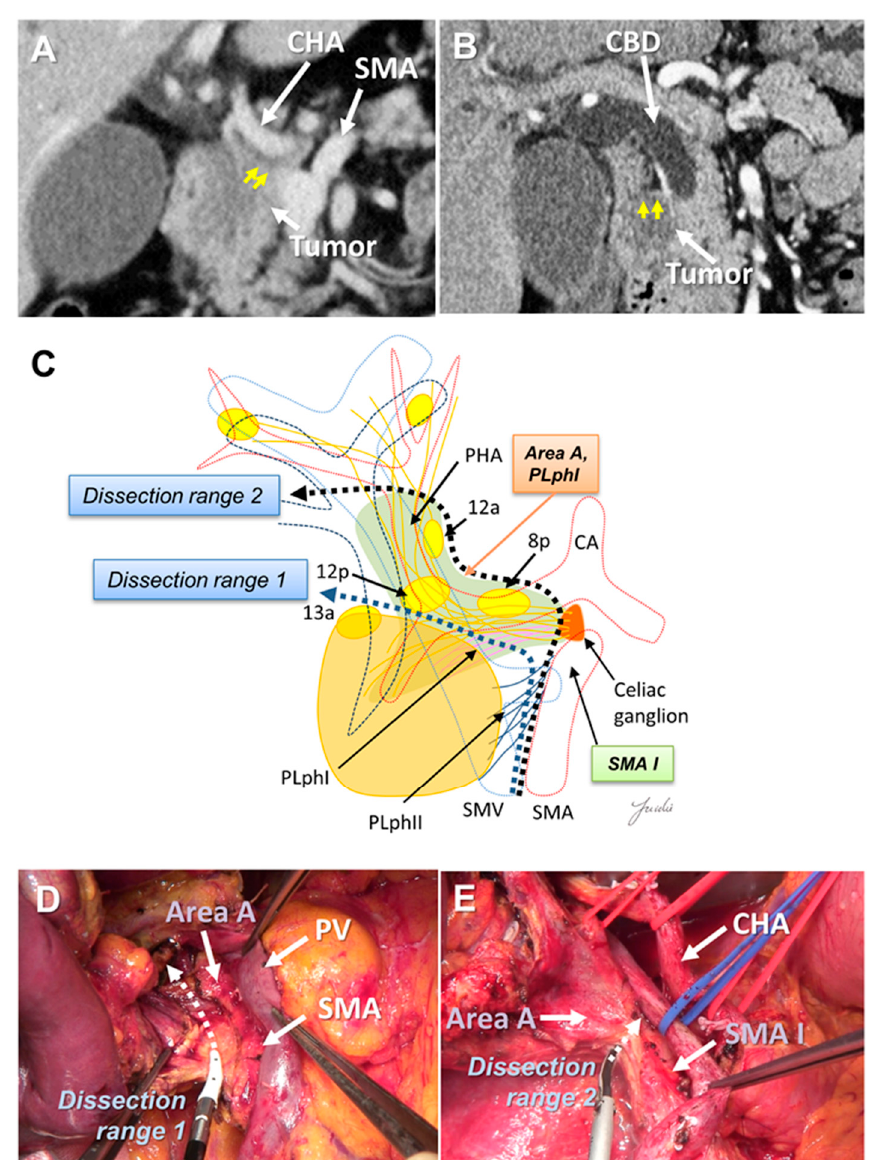
Figure 2. ( A ) Tumor extension is observed near the CHA root and SMA root on the preoperative MDCT findings. ( B ) Tumor extension is observed near the hepatoduodenal ligament. ( C ) Determination of the dissection range based on the MDCT findings. Dissection ranges 1 and 2 can be selected based on the anatomical structure, depending on tumor extension toward to the hepatoduodenal ligament, CHA root, and SMA root. ( D ) Cutting line for dissection range 1. ( E ) Cutting line for dissection range 2. MDCT: multi-detector computed tomography; CBD: common bile duct; CA: celiac artery; CHA: common hepatic artery; SMA: superior mesenteric artery; SMV: superior mesenteric vein.